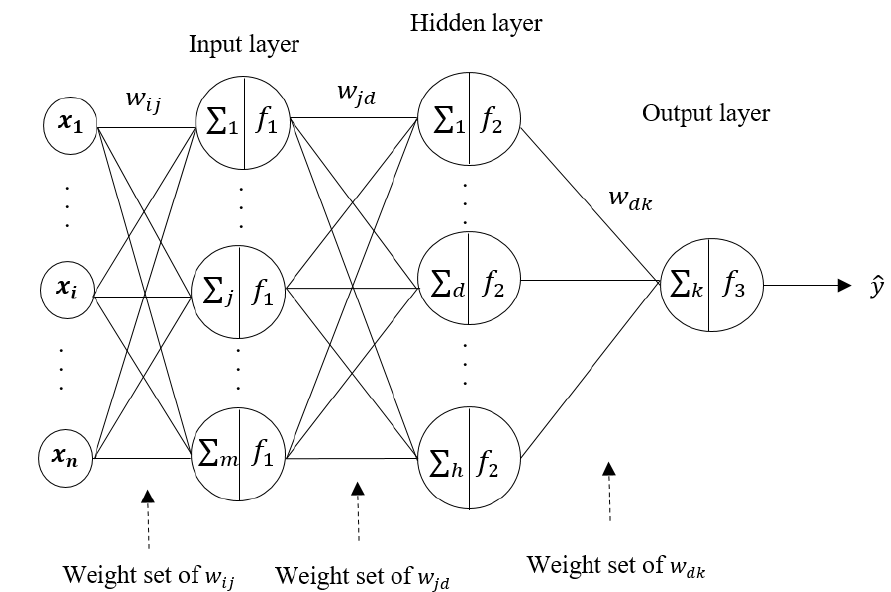
Fig. 2. Multi-layer perceptron neural network including tree layers